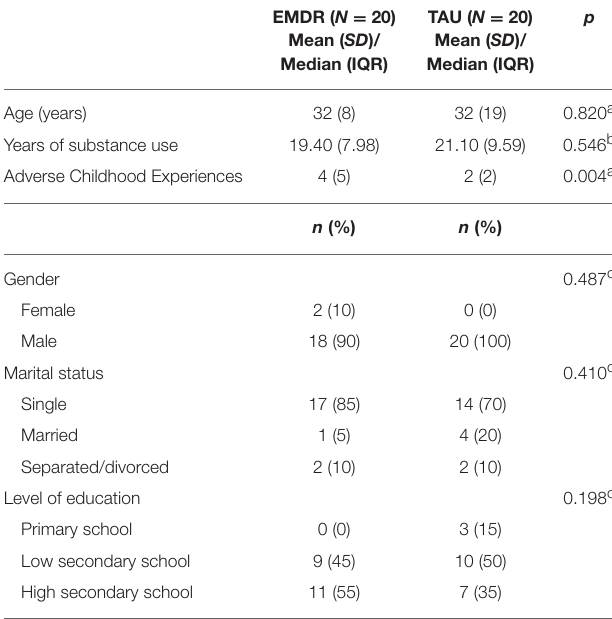
TABLE 1 | Demographic data of participants at